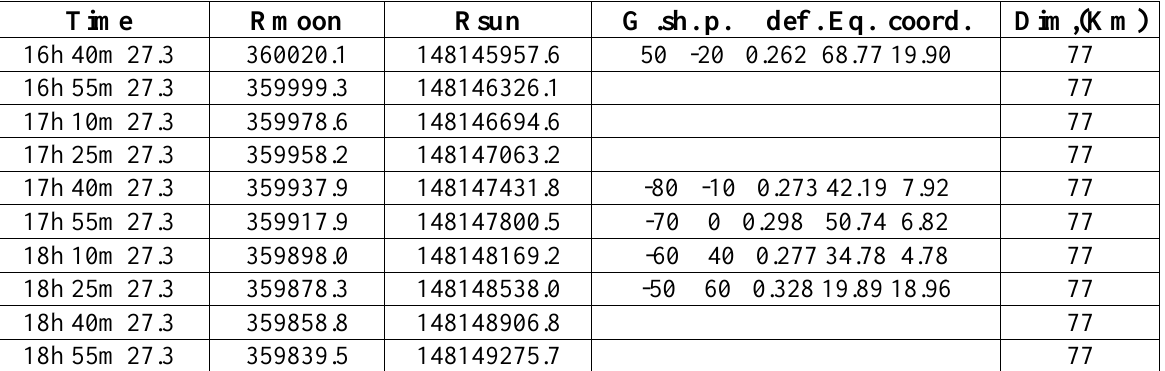
Table 3 : YY = .2163553301 Total CENTRAL